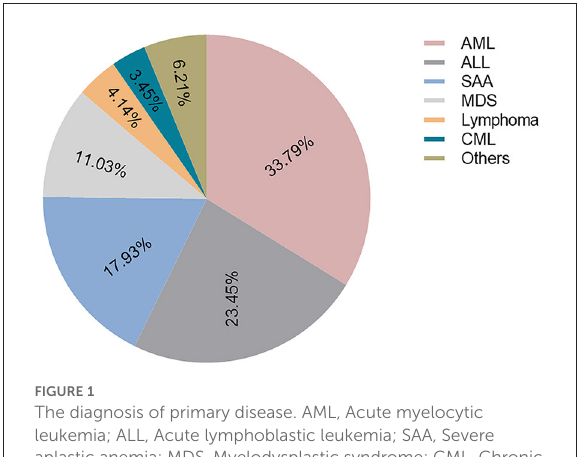
FIGURE1 The diagnosis of primary disease. AML, Acute myelocytic leukemia; ALL, Acute lymphoblastic leukemia; SAA, Severe aplastic anemia; MDS, Myelodysplastic syndrome; CML, Chronic myeloid